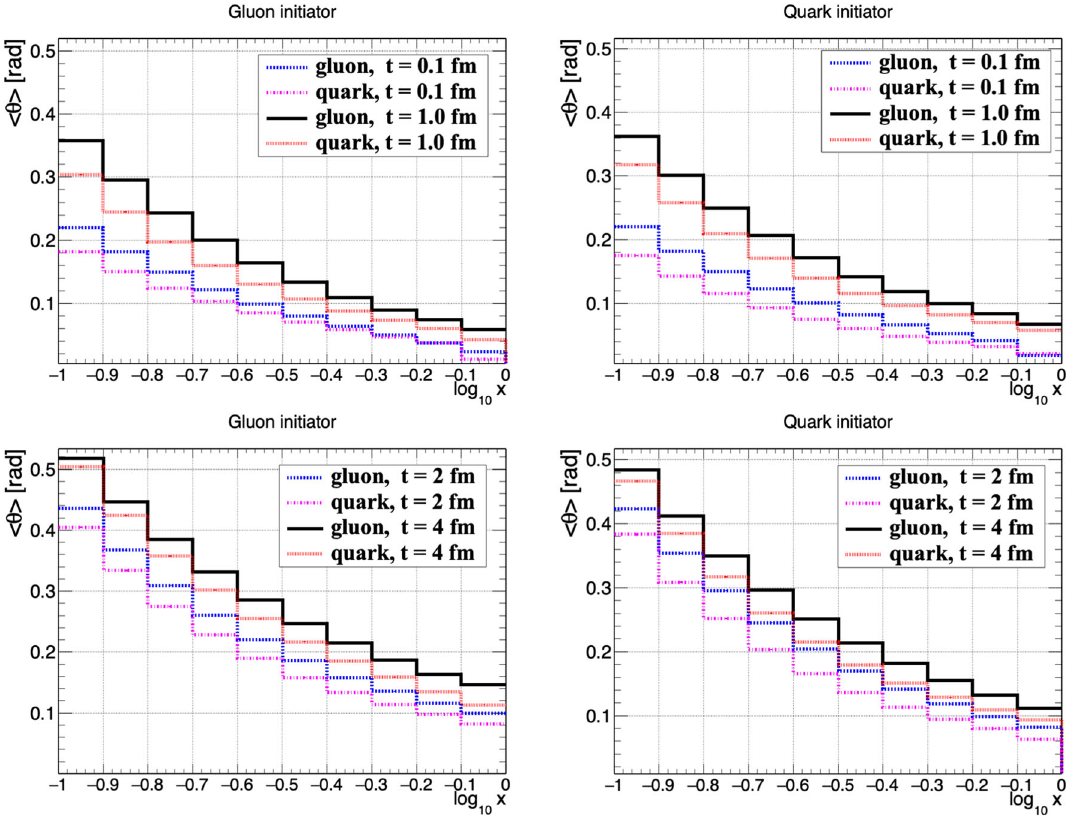
Fig. 9 Theaveragepolarangle (cid:2) θ (cid:3) versuslog 10 x fortheevolutionequations(20)with w( l ) ∝ 1 / [ l 2 ( m 2